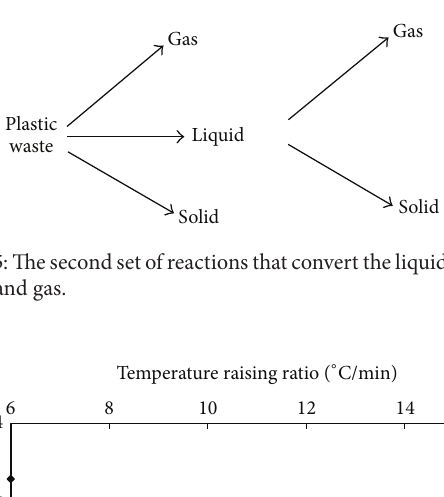
Figure 3: The effect of temperature increasing rate on gas product of each plastic compound.